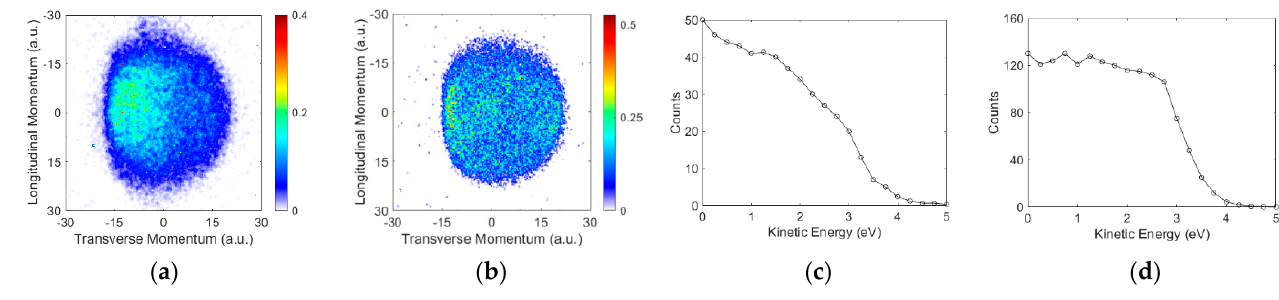
Figure 5. Momentum images obtained for the H − ions from ( a ) aniline at 8.9 eV and ( b ) benzylamine at 8.4 eV. The incoming electron beam direction is from top to bottom; ( c , d ) are the respective kinetic energy distributions.